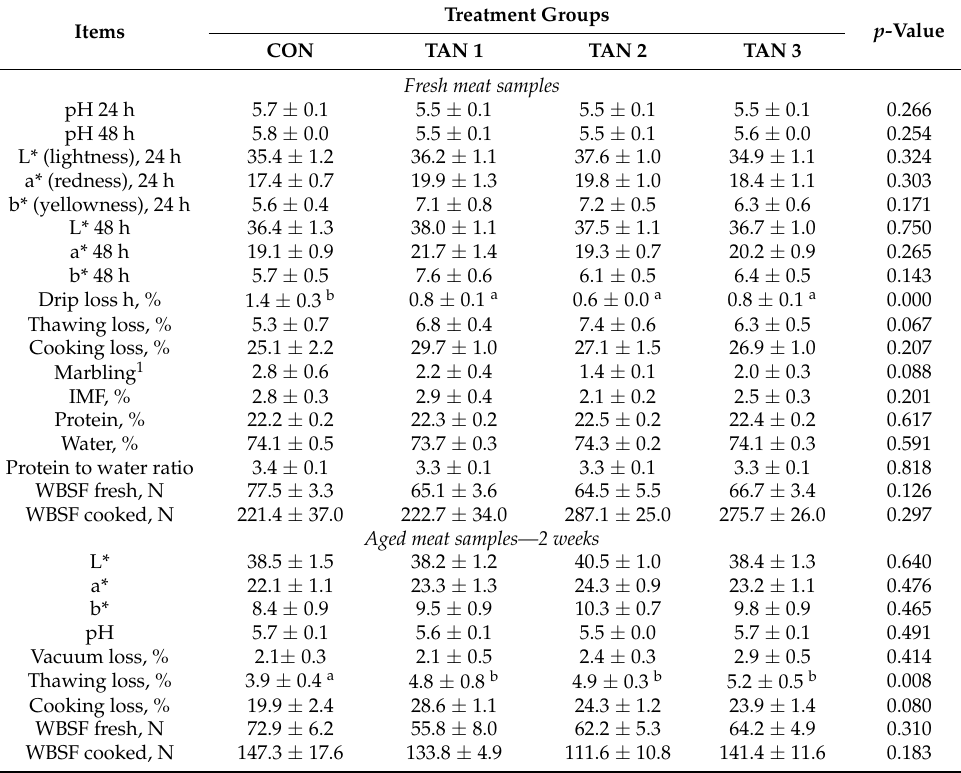
Table 5. Effect of supplemented hydrolyzable tannins on meat quality parameters of Limosin bull